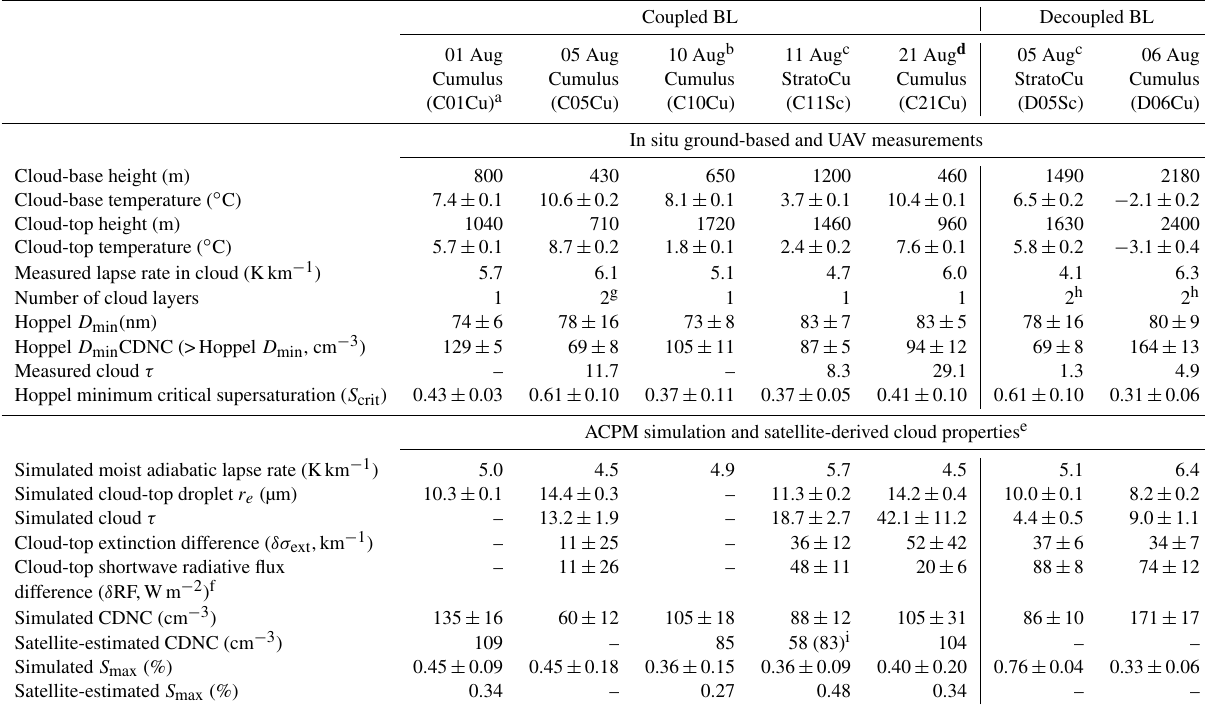
Table 2. UAV observations of cloud heights and temperatures and cloud property estimates based on ground measurements. Ground-based Hoppel minimum diameter ( D min ) is used to estimate CDNC. ACPM simulation and satellite results are also presented, as well as differences between simulated and observation-derived cloud-top extinction and cloud-top radiative flux. Case abbreviations include if they are coupled (C) or decoupled (D); the day of the month; and cloud type: cumulus (Cu) or stratocumulus